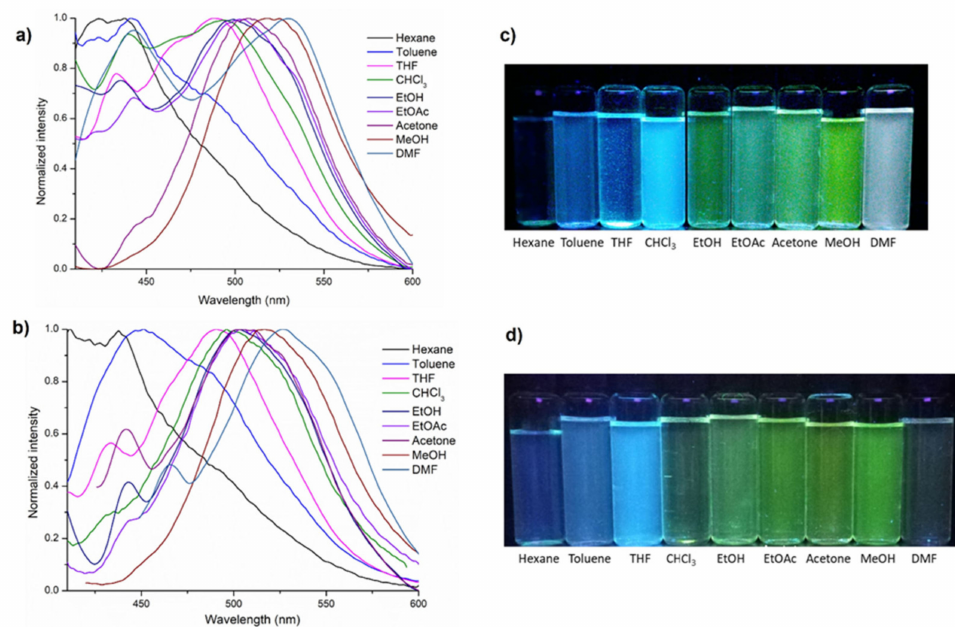
Figure 12. Normalized photoluminiscence spectra ( λ ex = 389 nm) of 1 ( a ) and 2 ( b ), respectively, in different solvents (1.0 × 10 − 5 M, slit: 10/6). Photographic images of 1 ( c ) and 2 ( d ) in various solvents under a UV lamp (1.0 × 10 − 5 M, λ ex = 365